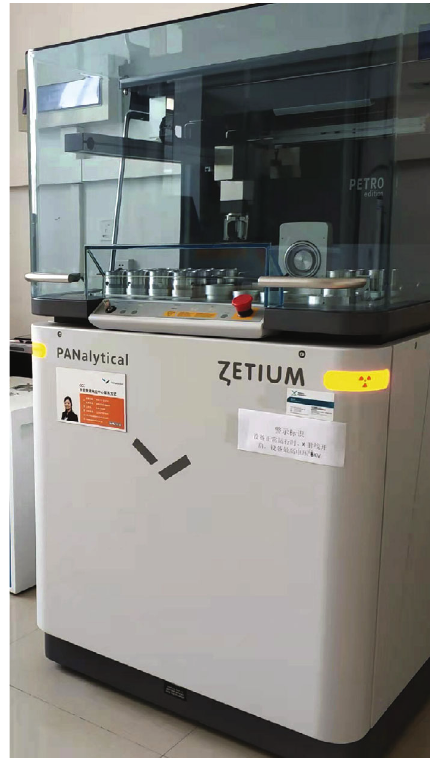
Figure 2: XRF test system.